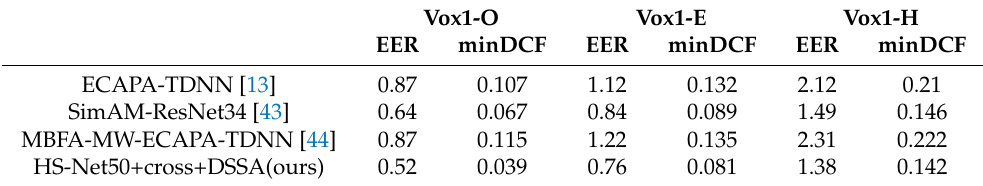
Table 4. Comparison of EERs of our proposed model with